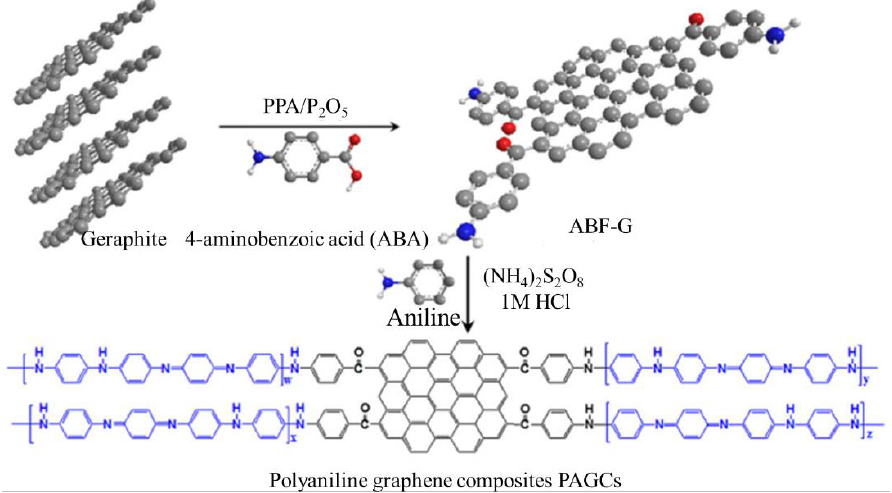
Figure 33. Preparation of PANI/graphene composites (PAGCs). Reprinted from Carbon N. Y., 50